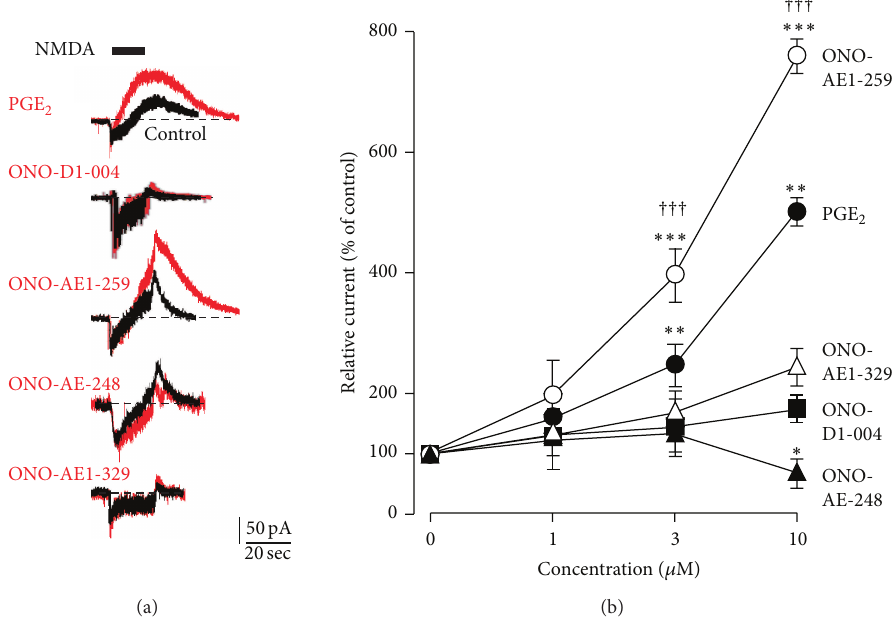
Figure 1: Potentiation of NMDA-induced outward currents through the activation of EP2 receptors in the acutely dissociated mouse cortical neurons. (a) Superimposed traces show NMDA-induced currents in the absence (black traces) or the presence (red traces) of drugs. PGE 2 (10 𝜇 M), ONO-DI-004 (an EP1 receptor agonist, 10 𝜇 M), ONO-AE1-259 (an EP2 receptor agonist, 10 𝜇 M), ONO-AE-248 (an EP3 receptor agonist, 10 𝜇 M),and ONO-AE1-329 (anEP4 receptor agonist,10 𝜇 M)weresimultaneously applied withNMDA(30 𝜇 M).Ablack lineindicates the drug application period. Broken lines indicate basal currents. Calibration bars are 50 pA and 20sec. (b) Dose response of EP receptor agonists on NMDA-induced outward currents. The symbols and bars represent the mean ± SEM ( 𝑛 = 5–7 cells in each responses). Asterisks indicate a significant difference from 0 𝜇 M ( ∗ 𝑃 < 0.05 , ∗∗ 𝑃 < 0.01 , and ∗∗∗ 𝑃 < 0.001 , one-way ANOVA with post hoc Dunnett’s test). Swords indicate a significant difference between PGE 2 and ONO-AE1-259 ( ††† 𝑃 < 0.001 , 𝐹 1,40 = 47.28, two-way ANOVA Bonferroni